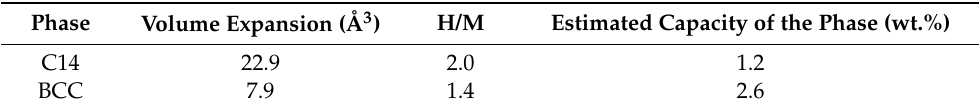
Table 5. Estimated capacity of the phases in the hydrided sample.